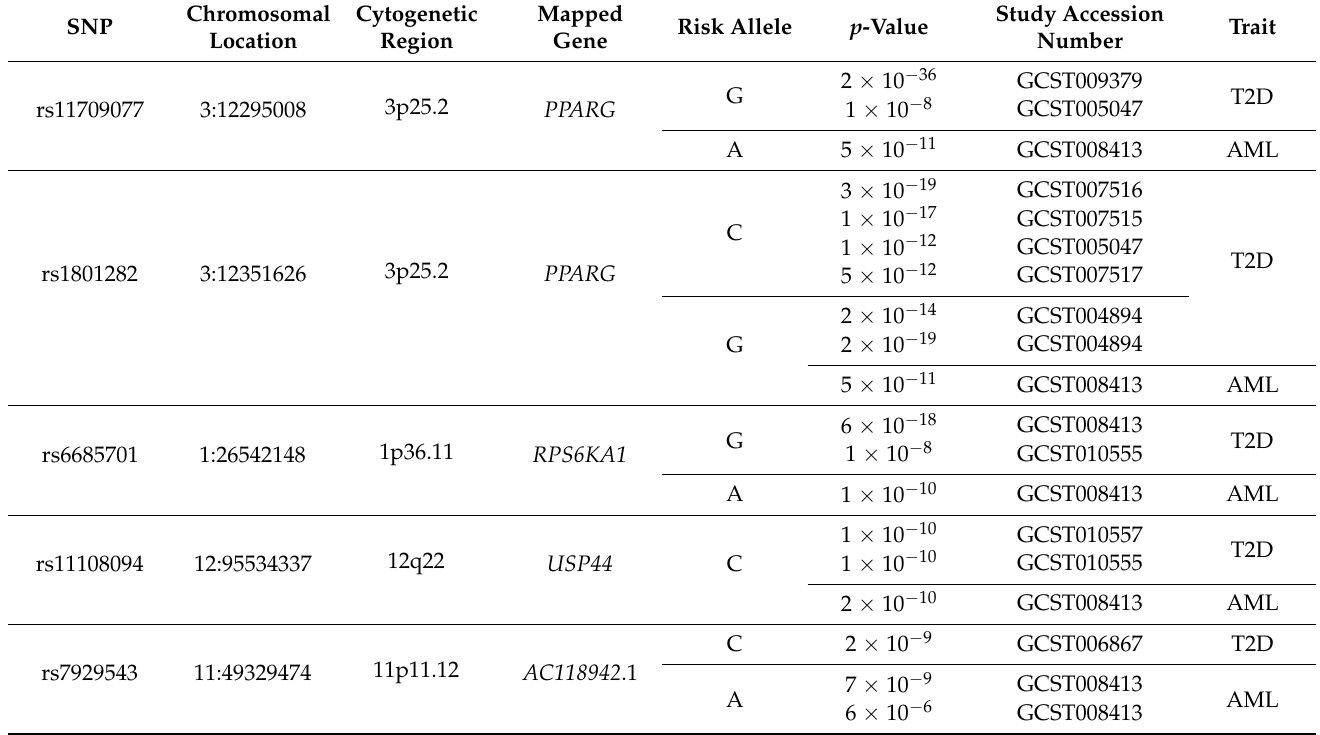
Table 1. Information about the five common SNPs associated with both AML and T2D, as obtained upon search in the NHGRI-EBI Catalog of genome-wide association studies (GWAS) (May 2021) [3]. Variant ID, chromosomal location, cytoge- netic region, mapped genes, risk alleles, p -values detected in each study, study accession numbers and the corresponding traits are